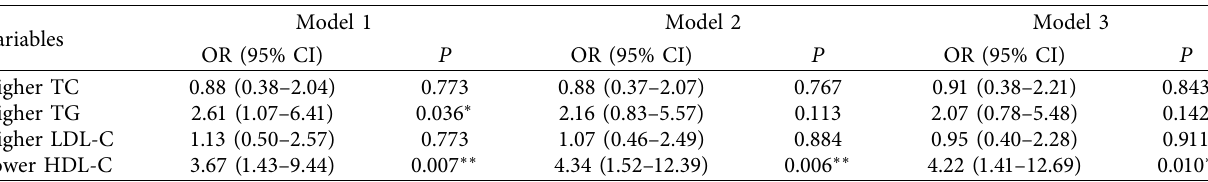
Table 3: Associations between high IPFD and dyslipidemia in 80 individuals with newly diagnosed